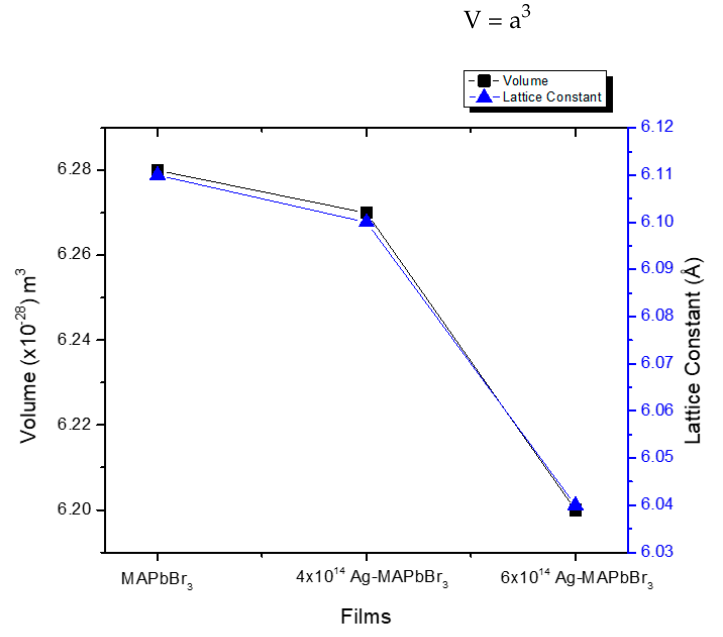
Figure 5. The volume and lattice constant of the thin film of pure MAPbBr 3 and Ag-irradiated MAPbBr 3 .